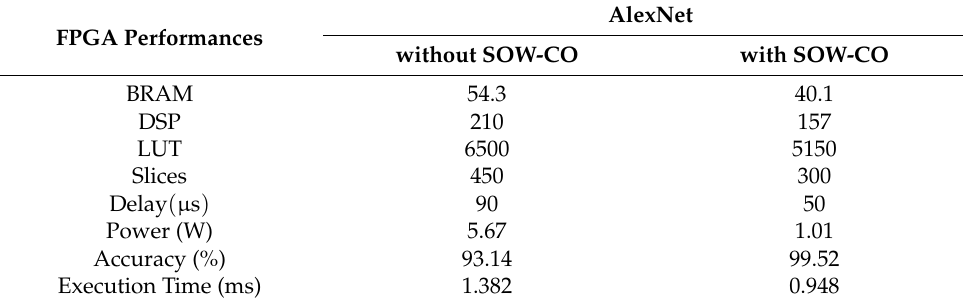
Table 8. Analysis of FPGA performances for